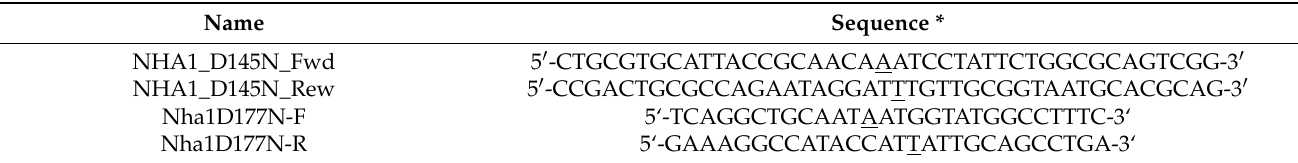
Figure A3. Changes in the phosphorylation state of Pma1 S899, S911, and T912 residues upon the overexpression of Ppz1. Data were extracted from reference [14] and are expressed as the ratio between Ppz1-overexpressing cells vs. wild-type cells (means ± SEM from four independent experiments). *, p < 0.05; **, p < 0.01; ***, p < 0.001. Table A1. Oligonucleotides used in this work